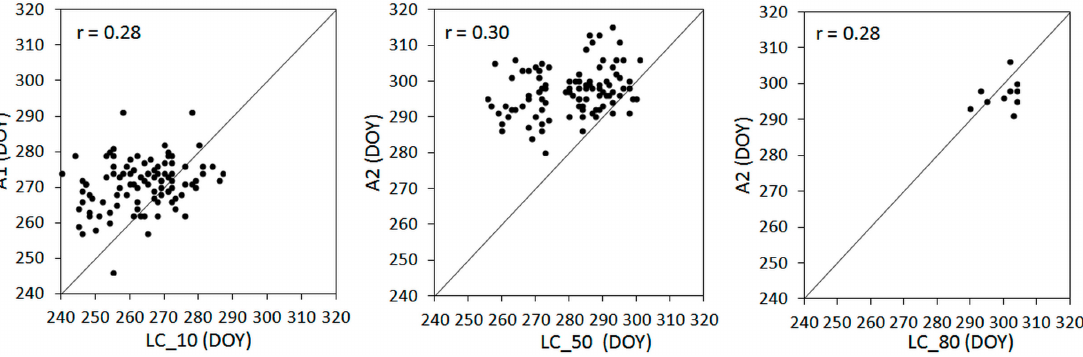
Figure 7. Correlation between the in situ observed autumn phenological phases and assigned autumn phenological metrics: A1 and beginning of leaf coloring LC_10 ( a ), A2 and general leaf coloring LC_50 ( b ), A2 and 80% leaf coloring LC_80 ( c ). The correlation was weak in all cases. DOY, day of year.